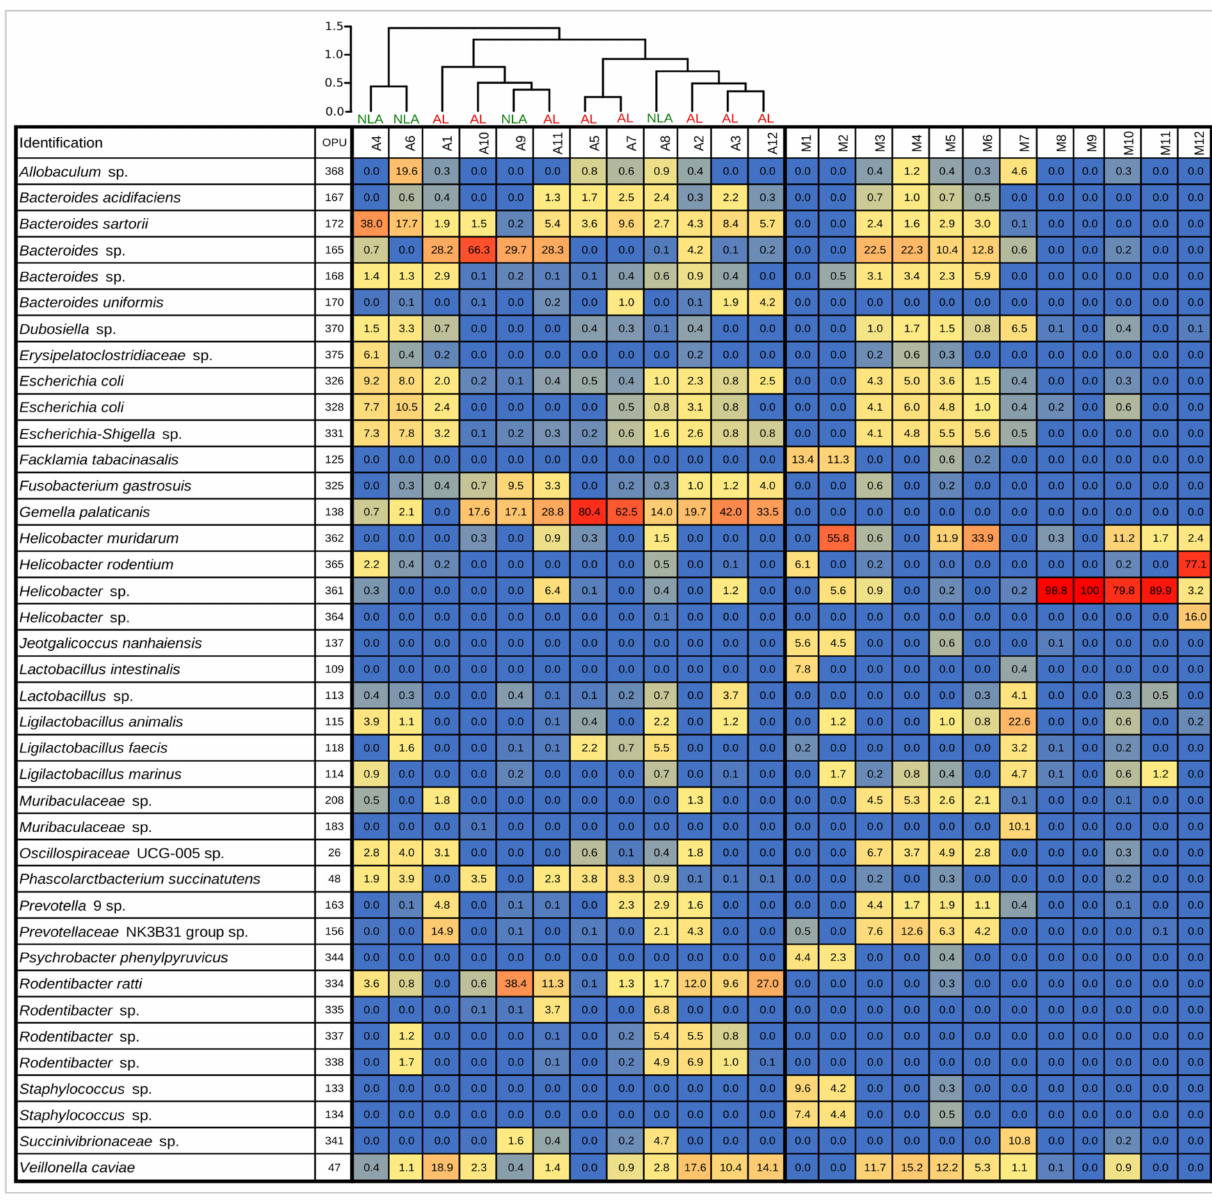
Figure 7. Heat map and dendrogram analyses . Heat map of relative abundances (%) of top OPUs per sample up to 5%. The inset color of blue indicates zero; yellow to increasing red values indicate above 1%. On top of experimental anastomosis samples (A), dendrogram analysis, Bray–Curtis distance method, and Ward’s clustering algorithm. M: control mucosa, A: anastomosis, NLA: non- leak anastomosis, AL: anastomotic